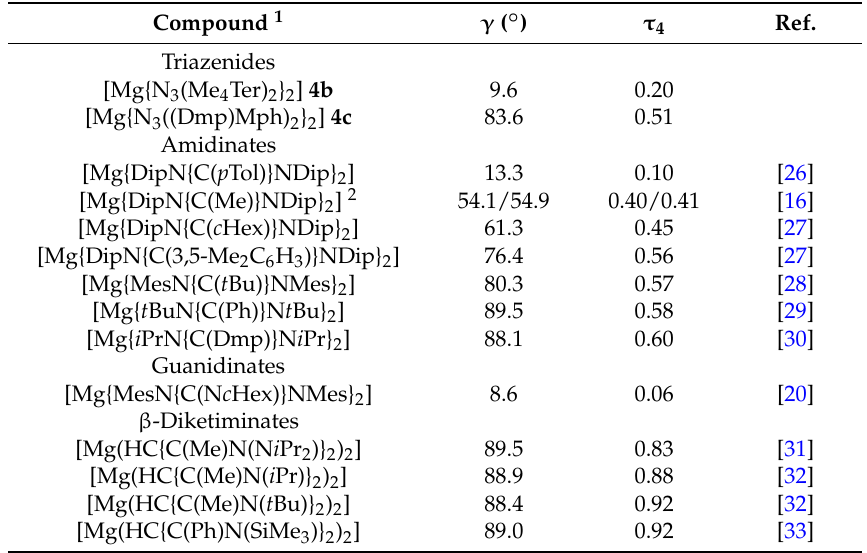
Table 1. Interplanar angles and τ 4 parameters [25] in four-coordinate magnesium triazenides, amidinates, guanidinates and β